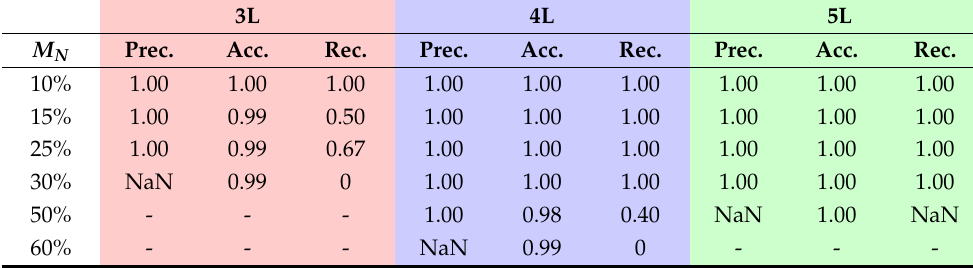
Table 5. Attack 2 detection results considering measurement